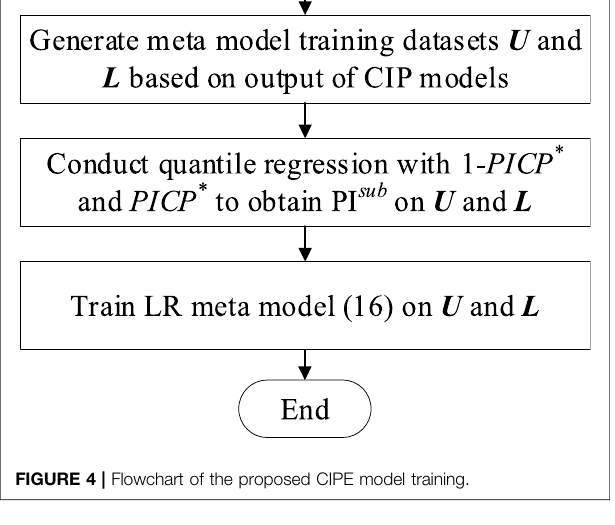
FIGURE 4 | Flowchart of the proposed CIPE model